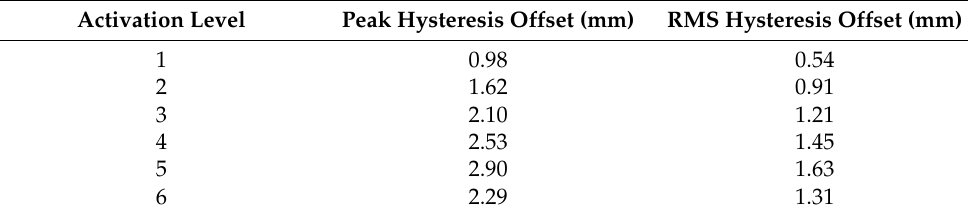
Table 3. Calculated peak and RMS hysteresis per activation level for the stroke characterisation